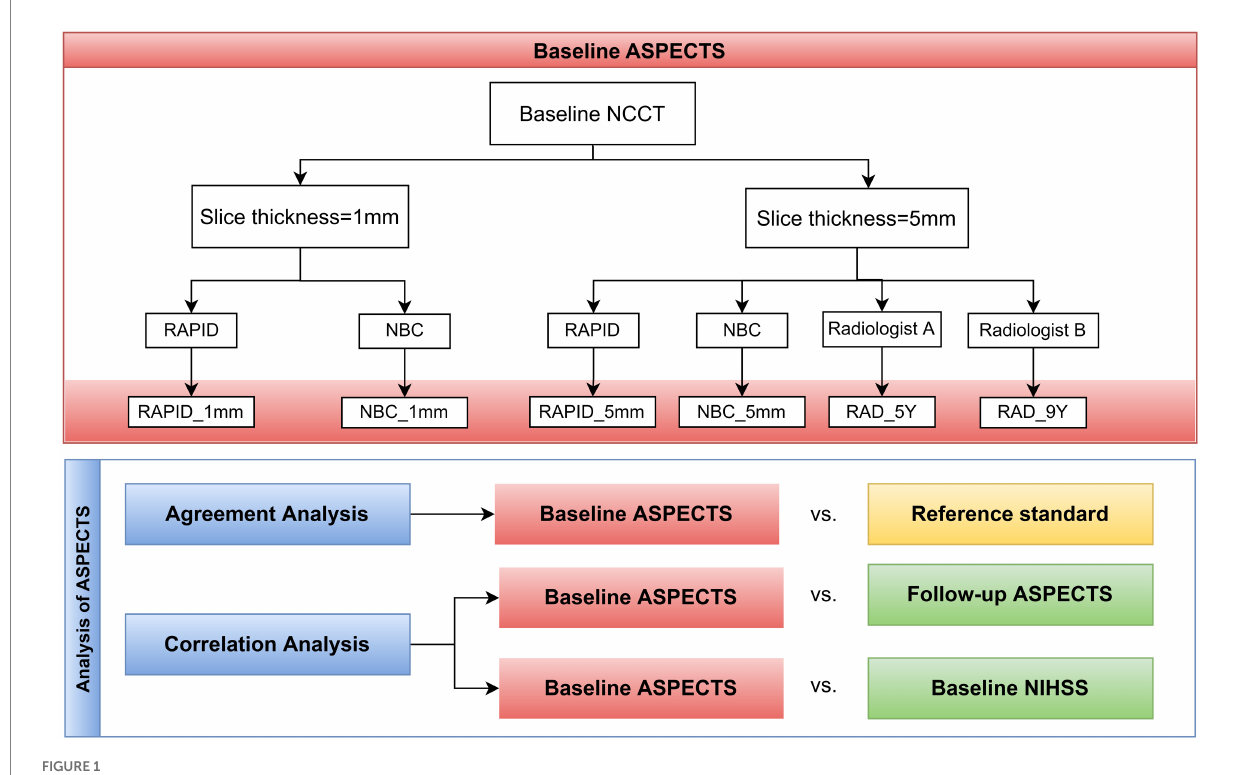
FIGURE 1 Workflow diagram of the